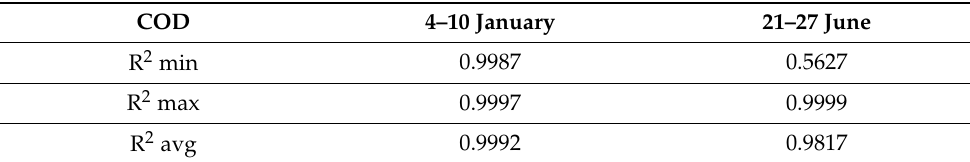
Table 2. Goodness of fit parameters of wall temperature for individual weeks.